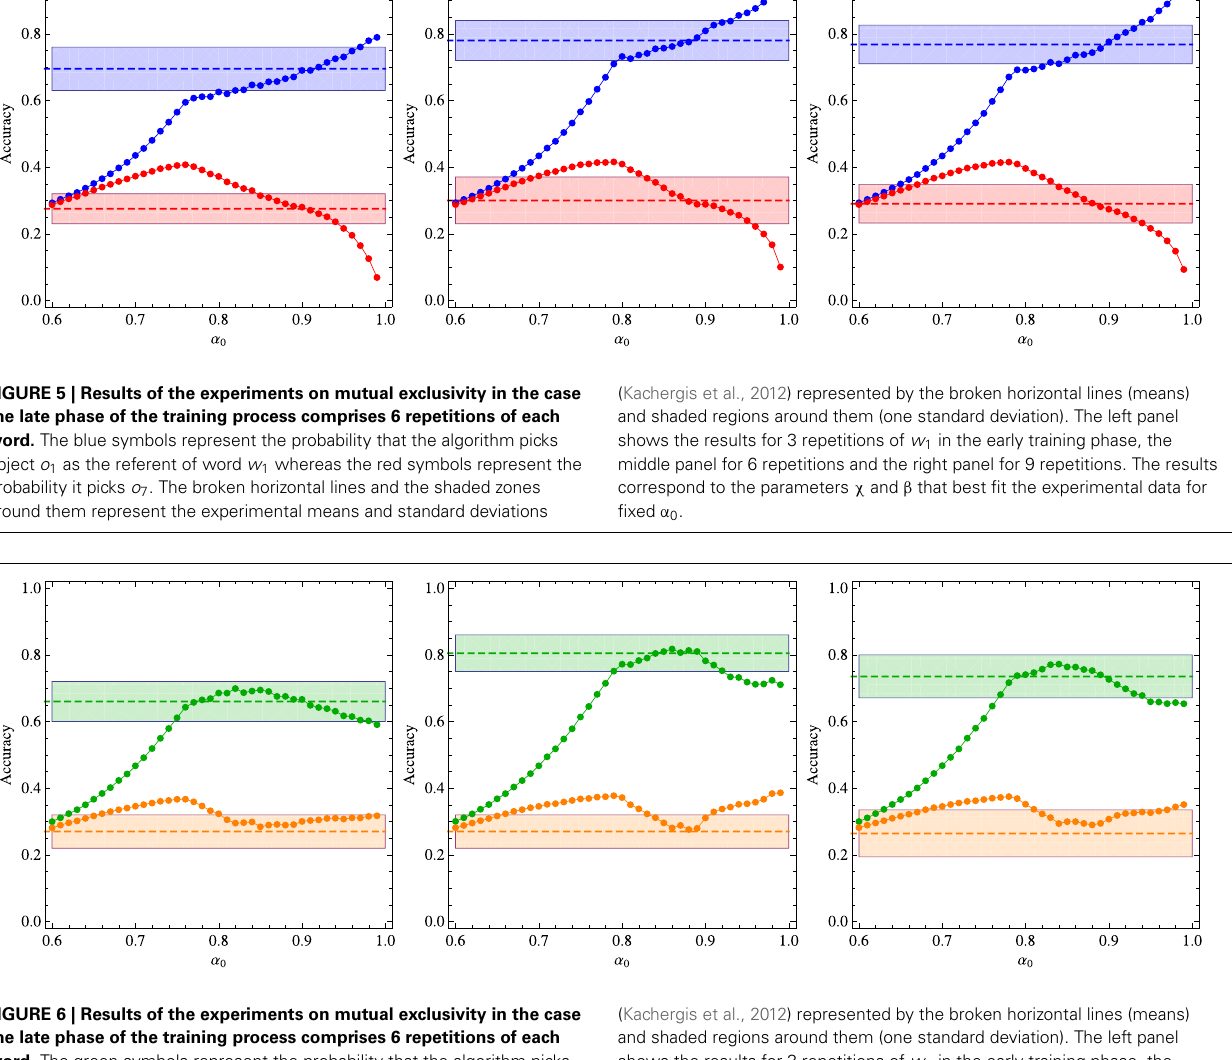
(Kachergis et al., 2012) represented by the broken horizontal lines (means) and shaded regions around them (one standard deviation). The left panel shows the results for 3 repetitions of w 1 in the early training phase, the middle panel for 6 repetitions and the right panel for 9 repetitions. The results correspond to the parameters χ and β that best fit the experimental data for fixed α 0